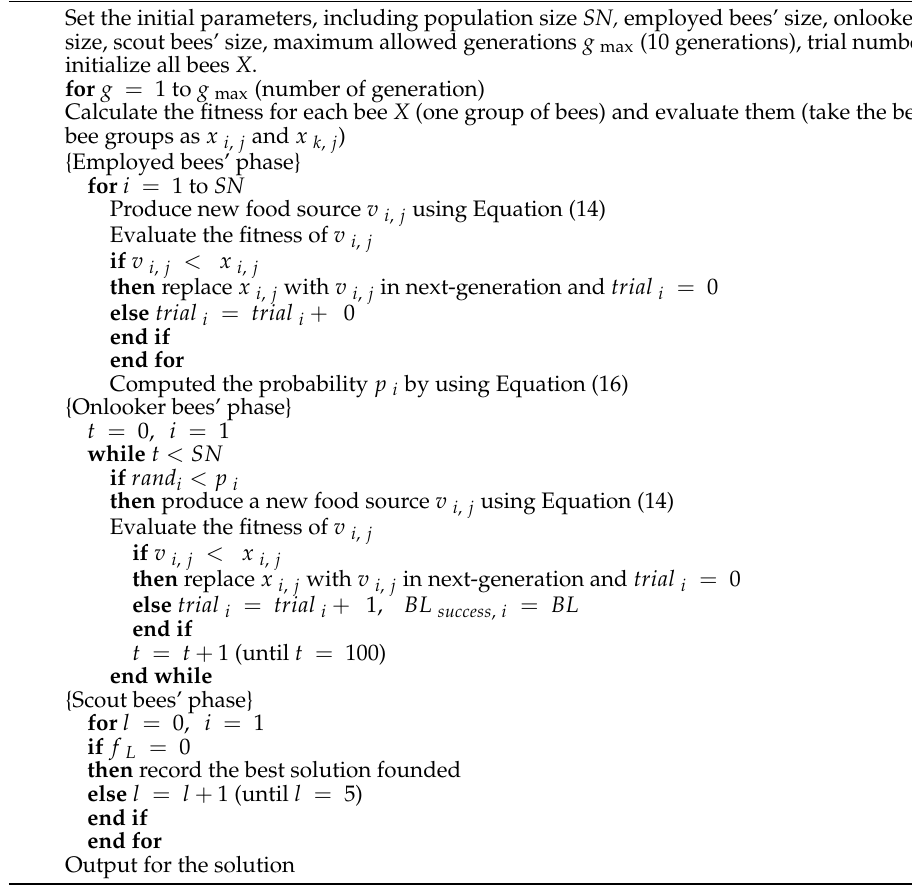
Algorithm 1. The pseudocode of ABC in the logic